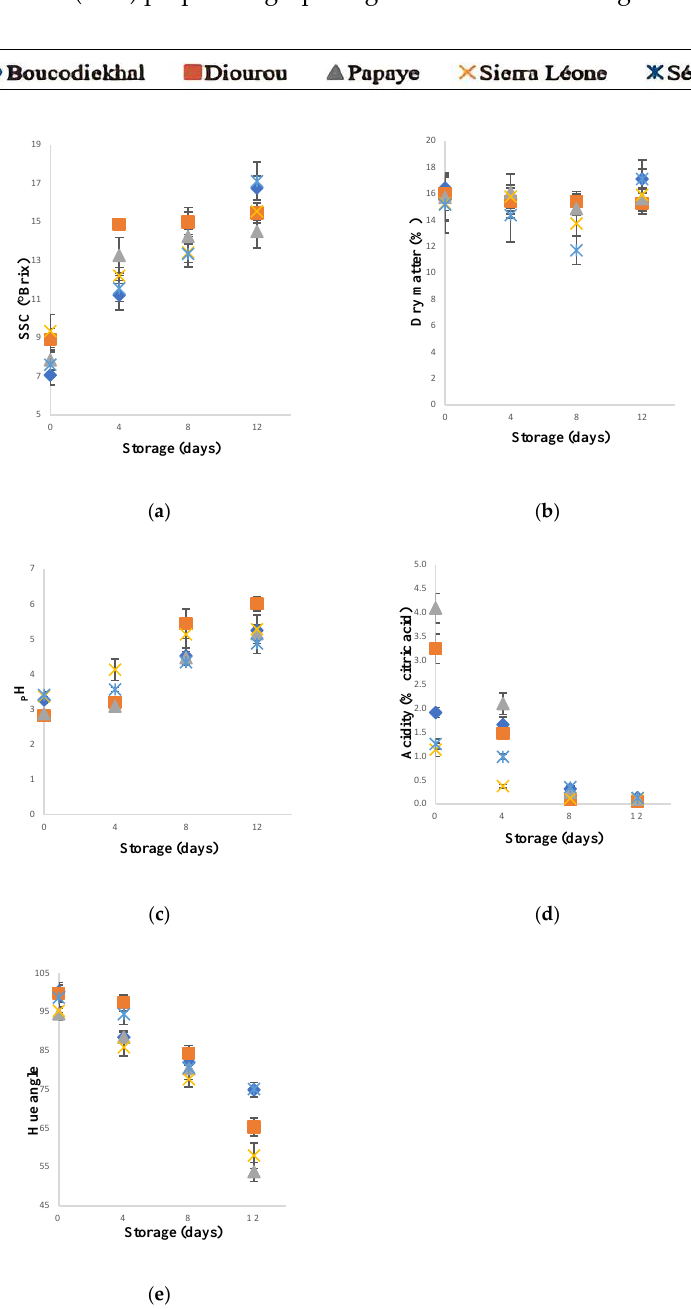
Figure 3. Physicochemical parameters of the five local varieties pulp during ripening storage. ( a ) SSC, ( b ) DM, ( c ) pH, ( d ) TA, ( e ) Hue. Each point represents mean value of n = 5 mango fruits × 2 trials per fruit with standard deviation